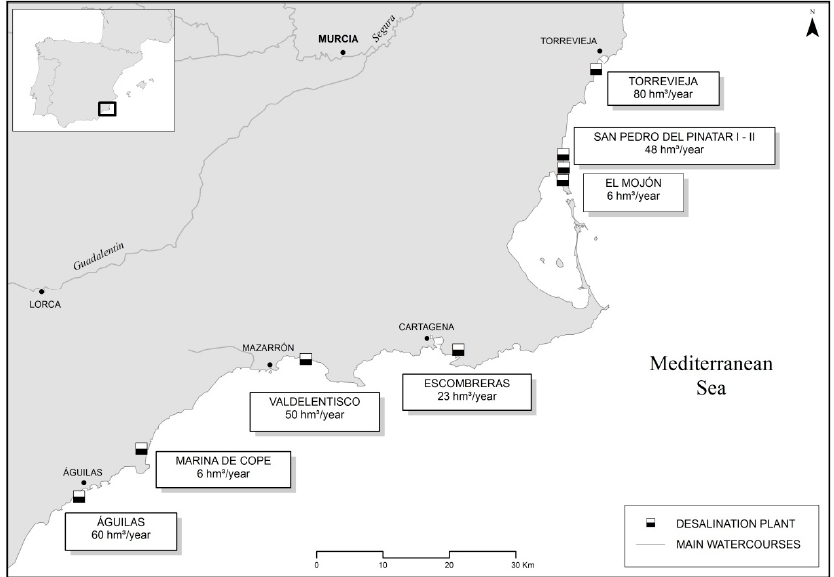
Figure 3. Location of the desalination plants of the Segura River Basin (own elaboration). Table 2. Situation of the main desalination plants in the Segura River Basin